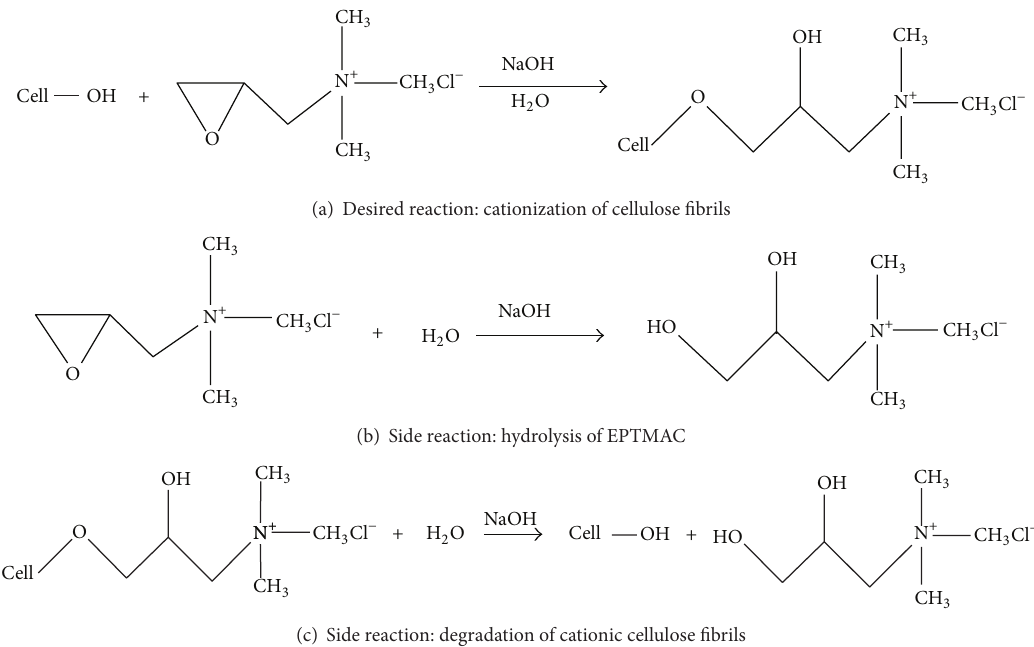
Figure 1: Competitive reactions during the cationic modification of cellulose fibrils using EPTMAC/H 2 O/NaOH System.